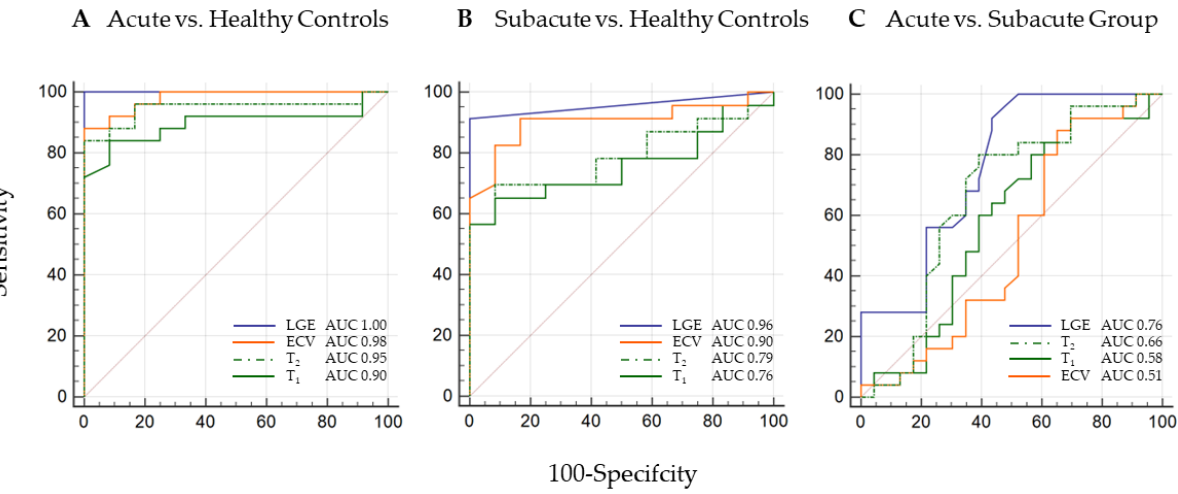
Figure 1. CMR Parameter ROC Curves for Discrimination of Subacute Myocarditis from Healthy Controls and Acute Myocarditis. ( A ) ROC curves demonstrate excellent areas under the curve (AUCs) for all four tissue characterization parameters for discrimination of acute myocarditis from healthy controls. ( B ) In the discrimination of subacute myocarditis from healthy controls, LGE and ECV performed best with AUCs of 0.96 ( p < 0.0001) and 0.90 ( p < 0.0001) respectively; 0.79 ( p < 0.001) for T 2 with a criterion of >49 ms; 0.76 ( p = 0.002) for T 1 with a criterion of >1015 ms. ( C ) For compar- ison of acute from subacute myocarditis, the areas under the curve (AUCs) were 0.76 ( p < 0.001) for LGE with a criterion of >2, 8% of LV myocardial mass; 0.66 ( p = 0.049) for T 2 with a criterion of >51 ms; T 1 and ECV showed no significant differences. The diagonal line course indicates difficult dis- crimination of acute vs. subacute myocarditis by CMR alone. The best diagnostic performance in the detection of subacute myocarditis and the discrimination from healthy controls was achieved by both ECV evaluation alone or in combination with T 1 mapping (applying a segmental or global increase of native T 1 > 1015 ms and ECV > 28%), demonstrating a sensitivity of 96% (CI 78 – 100) and an accuracy of 91% (CI 77 – 98), see Figure 2. Figure 2. Diagnostic Performance of CMR Criteria Combination for Discrimination of Subacute Myocarditis from Healthy Controls. The best diagnostic performance in the detection of subacute myocarditis and the discrimination from healthy controls was achieved by both ECV evaluation alone or in combination with T 1 mapping, demonstrating a sensitivity of 96% (CI 78 – 100) and an accuracy of 91% (CI 77 – 98). A segmental or global increase of native T 1 > 1015 ms and ECV > 28% was applied, derived from ROC analysis. LLC = Lake Louise Criteria.